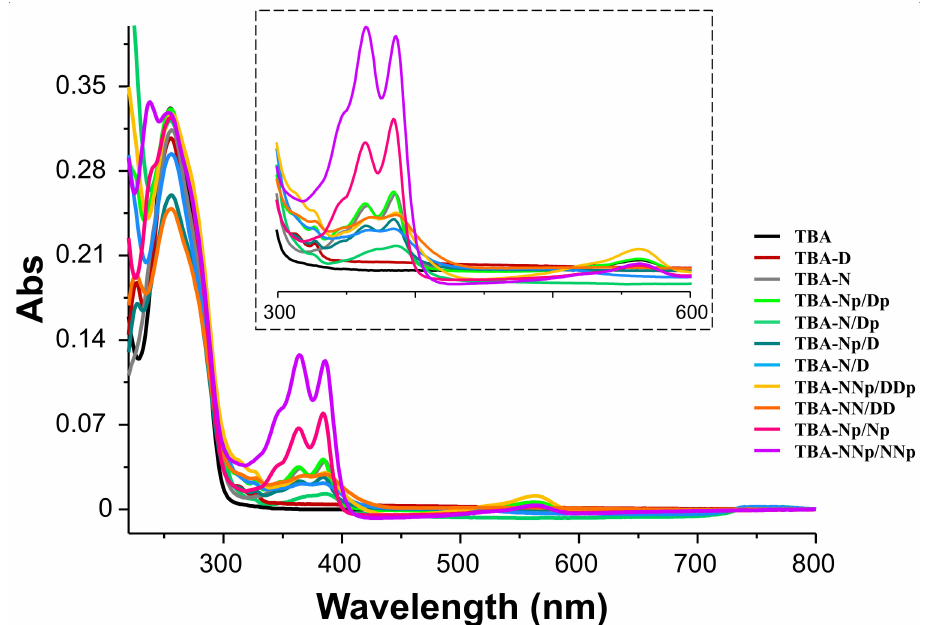
Figure 2. Overlapping UV-vis spectra of the pseudocyclic TBA derivatives in comparison with unmodified TBA, TBA-D and TBA-N, used as reference sequences. All the investigated oligonu- cleotides were analyzed at 2 µ M in H 2 O at room temperature. The inset shows an enlargement of the 300–600 nm region of the spectra, to better highlight the characteristic UV-vis contribution of naphthalene diimide groups and the charge transfer band around 560 nm or the NDI exciplex band.